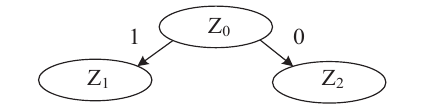
Fig. 5. A satellite navigation system signal after